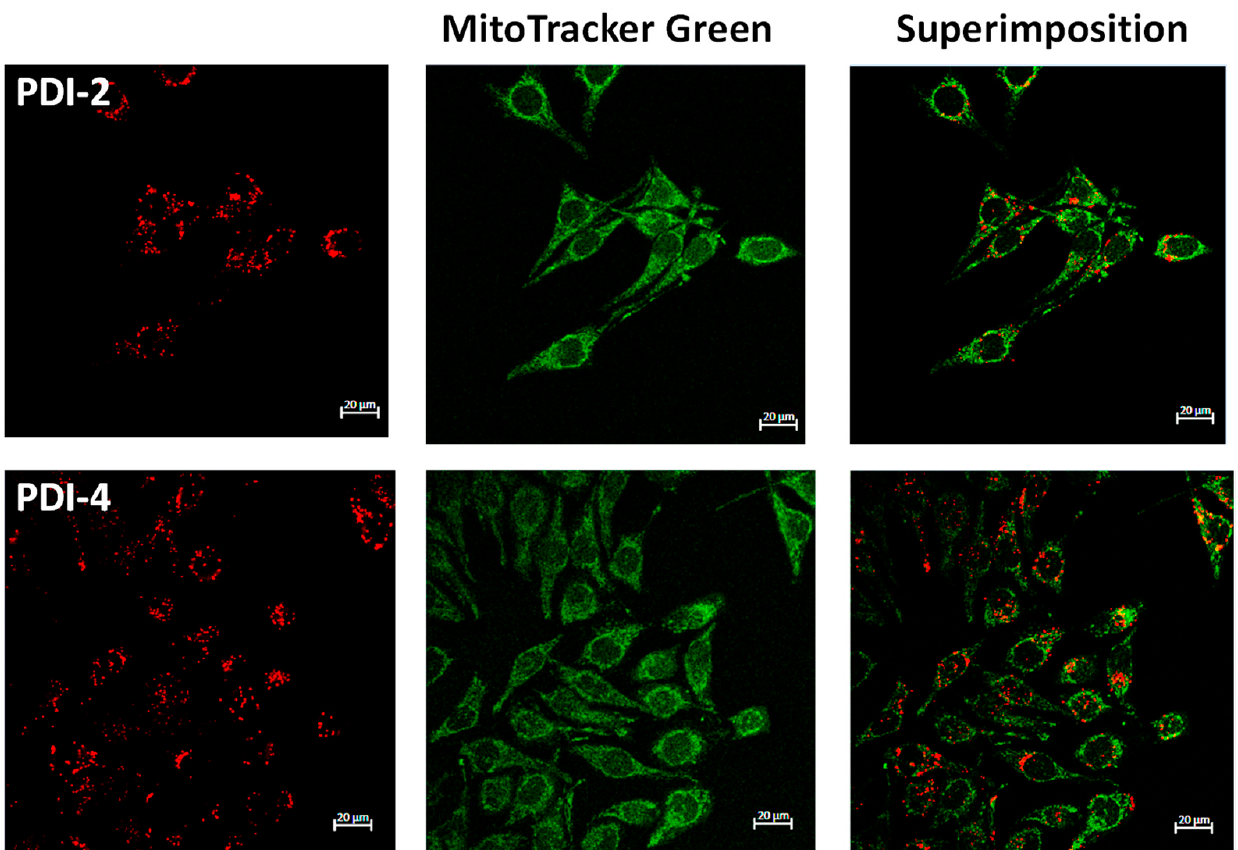
Figure 8. Fluorescence confocal microscopy images in HeLa cells incubated with the ligand PDI-2 and the copper complex PDI-4 at 2 h (red, irradiated at 561 nm) and stained with MitoTracker Green (green, irradiation at 488 nm).